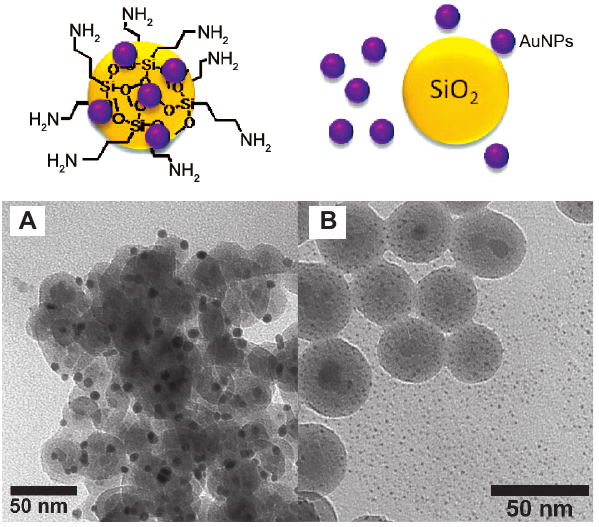
Figure 10 TEM images of gold NPs supported on (a) amino-func- tionalized and (b) nonfunctionalized